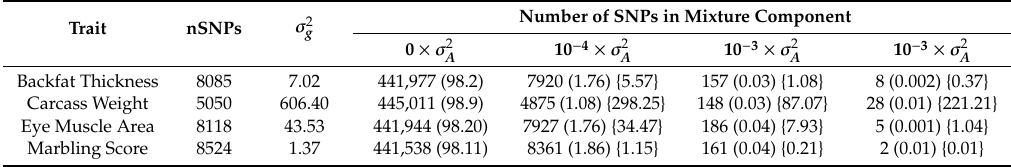
Table 3. Proportion of variants in each of the four distributions identified from BayesR analysis. Number of SNPs in Mixture Trait nSNPs σ 2 g